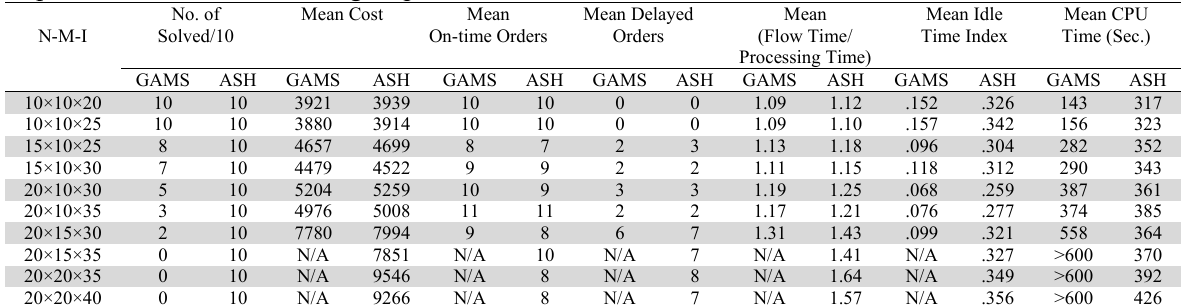
Fig. 2. Interruptions in machine idle time Experimental results to investigate performance measures in IAOS model